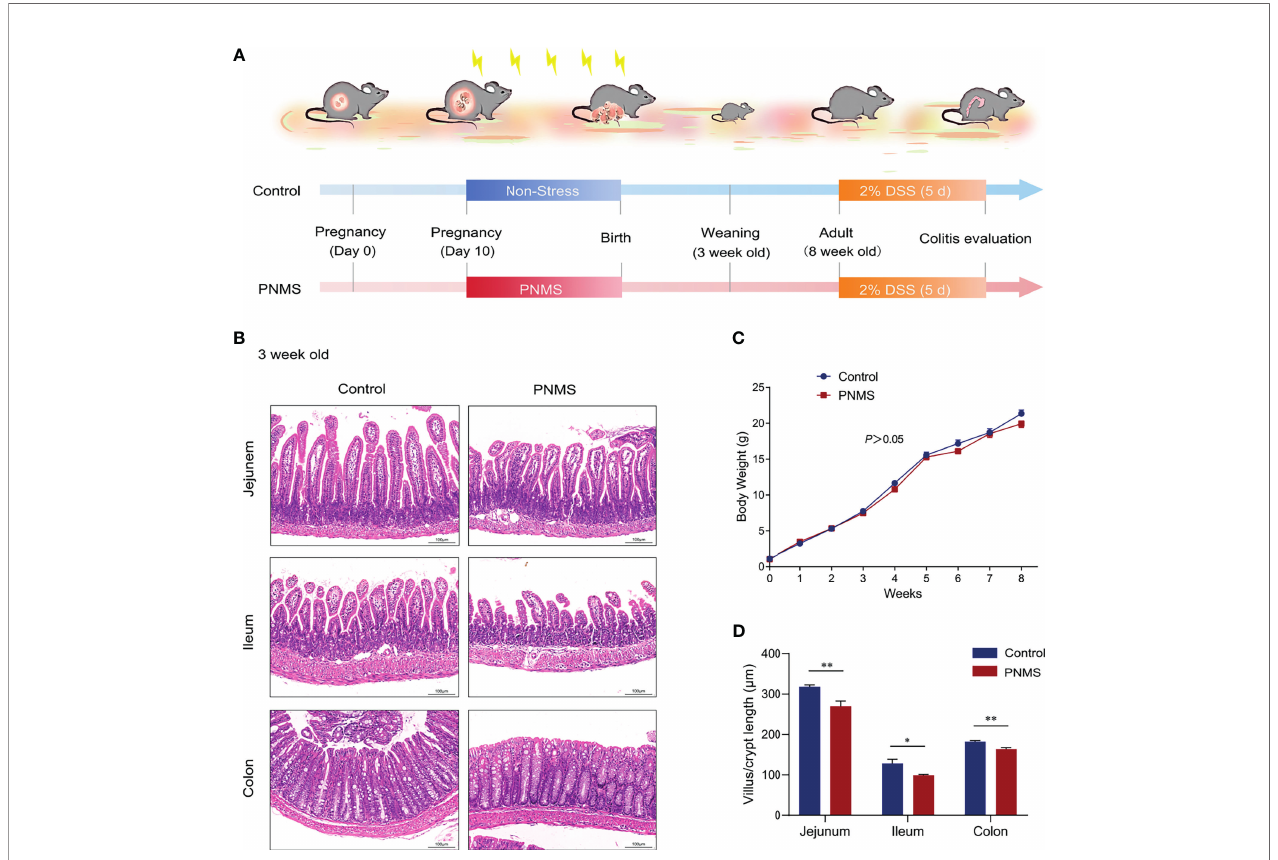
FIGURE 1 | Prenatal maternal stress impaired the intestinal development of 3-week-old offspring. (A) Flow diagram of the experimental procedure. (B) Microscopic observation of the intestinal and colonic development of 3-week-old pups with hematoxylin and eosin (HE) staining. (C) Changes in the body weight of offspring mice from week 0 to week 8. (D) Measurement of the villus lengths in the jejunum and ileum and the crypt depths of the colon. PNMS , prenatal maternal stress; DSS , dextran sulfate sodium. Scale bar , 100 m m. Magni fi cation, ×200. * p < 0.05, ** p < 0.01. PNMS ( n = 6) vs . control ( n =